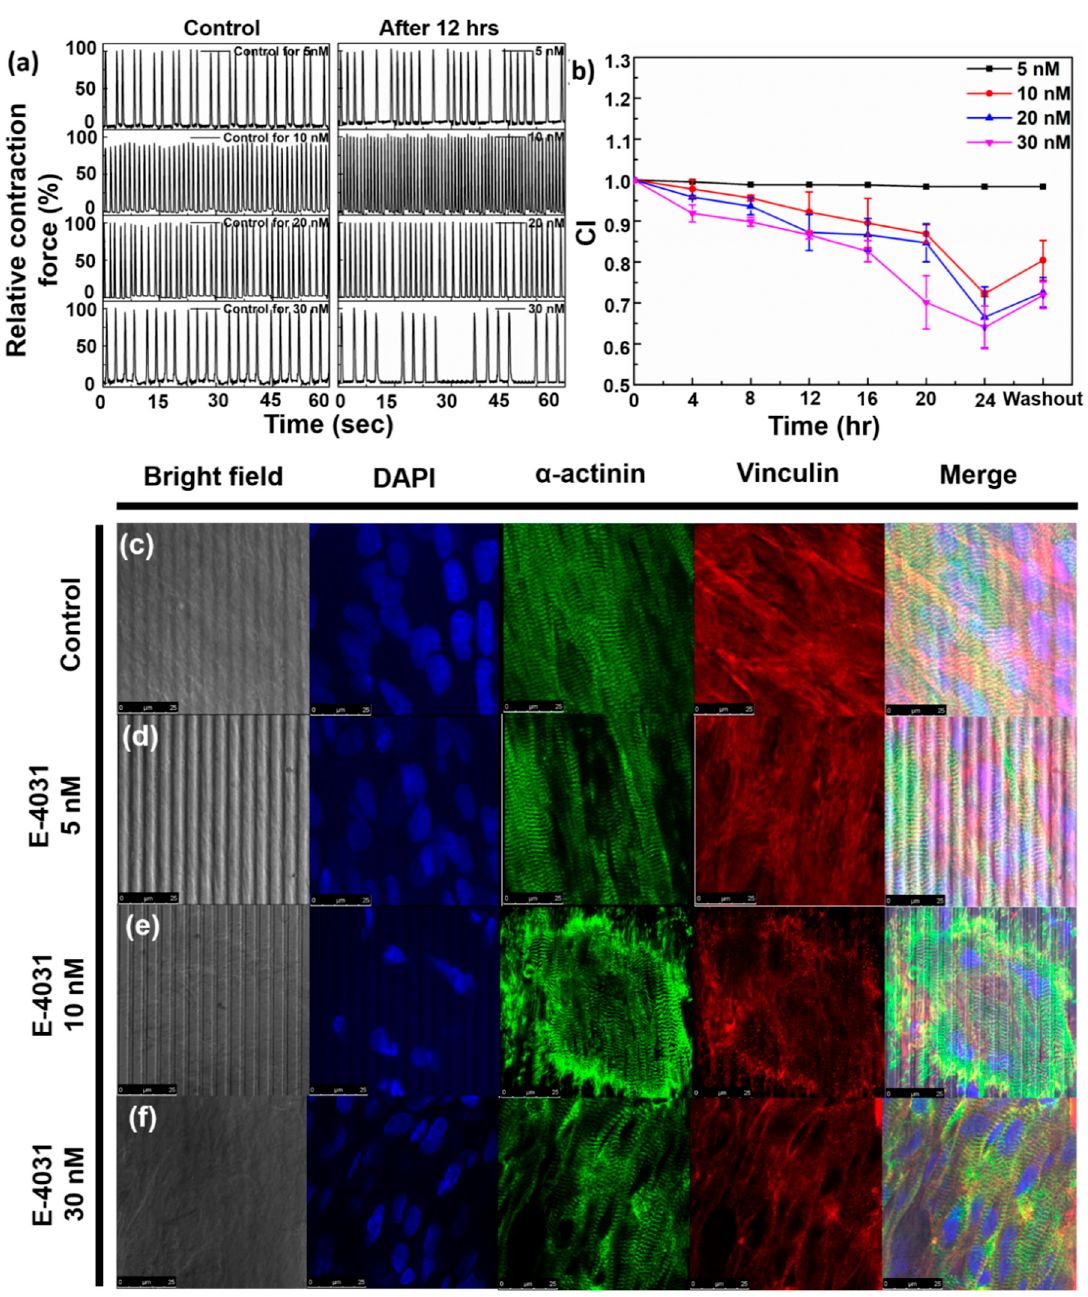
Figure 7. ( a ) Normalized contraction force on addition of E-4031 of concentrations 5 nmol/L, 10 nmol/L, 20 nmol/L, 30 nmol/L after 12 h, ( b ) Normalized impedance output on addition of E-4031 of concentrations 5 nmol/L, 10 nmol/L, 20 nmol/L, 30 nmol/L up to 24 h. ( c–f ) ICC staining data for ( c ) control, ( d ) 5 nmol/L, ( e ) 10 nmol/L, ( f ) 30 nmol/L E-4031. Scale bar = 25 µm.